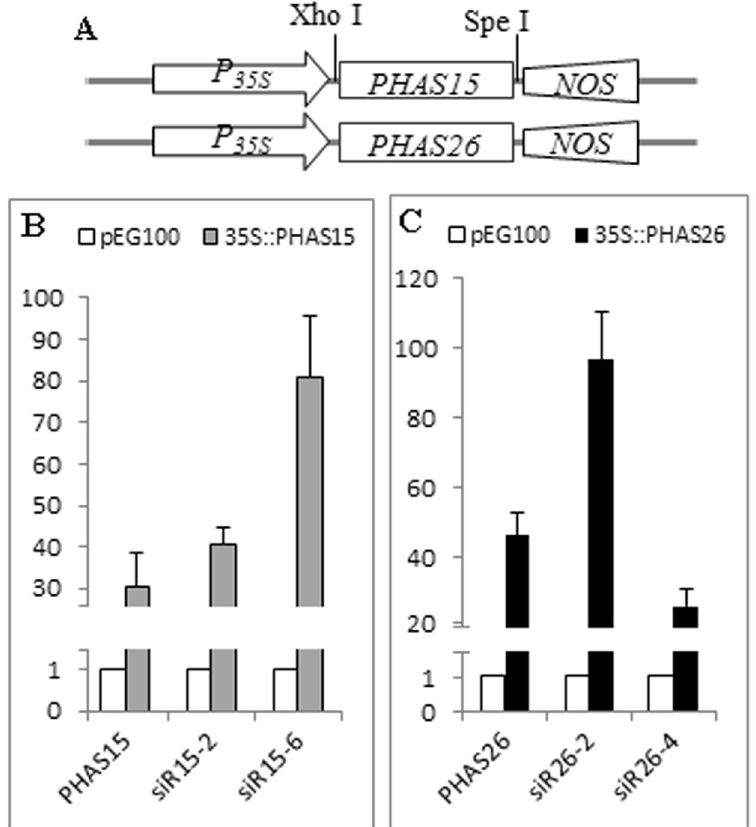
Figure 3. Transient overexpression. ( A ) Construction of the PHAS overexpression vectors. ( B ) The expression levels of PHAS15 and the corresponding phasiRNAs were detected in p35S::PHAS15-transformed leaves and control leaves. ( C ) The expression levels of PHAS26 and the corresponding phasiRNAs were detected in p35S::PHAS26-transformed leaves and control leaves. Ubi3 was used as the internal control. Error bars indicate SD from three biological repeats; the normalized levels of the control were set arbitrarily to